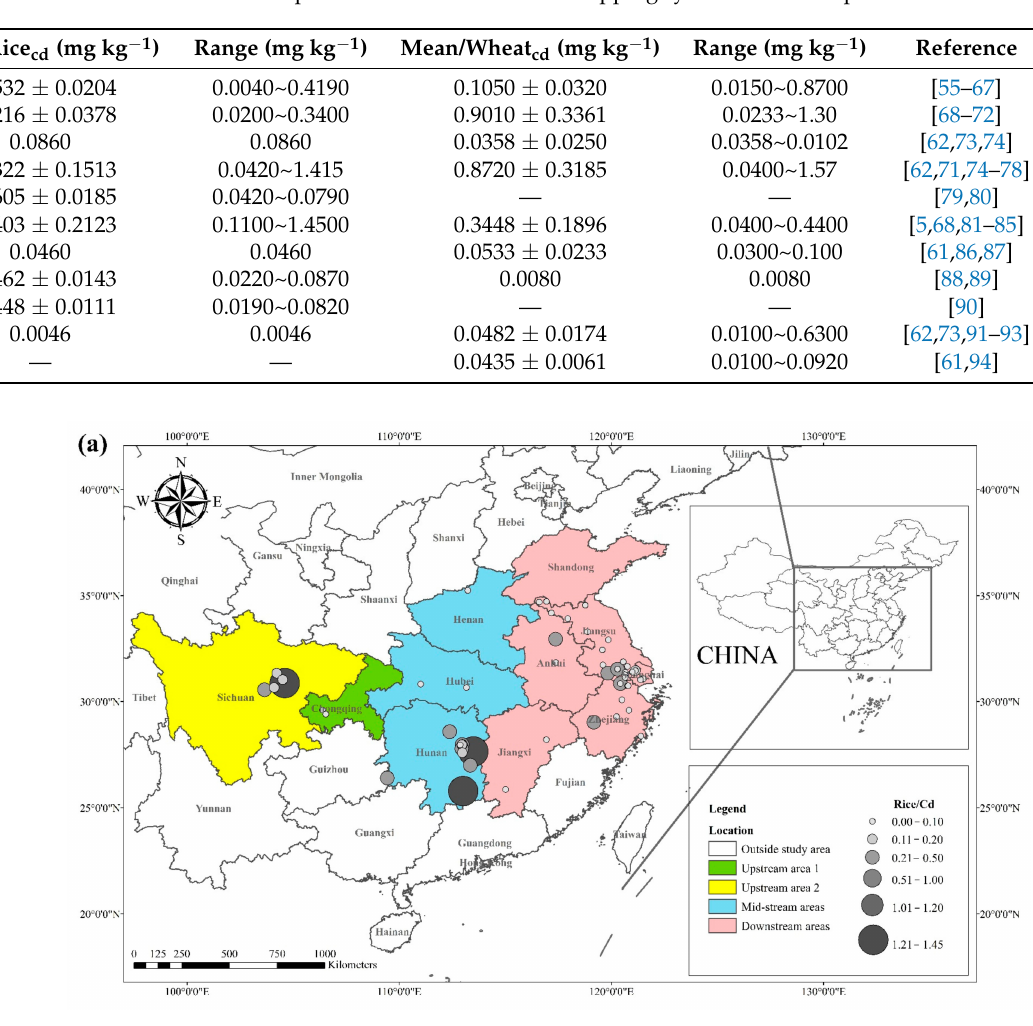
Table 1. The cadmium pollution of rice and wheat cropping systems in eleven provinces in China.